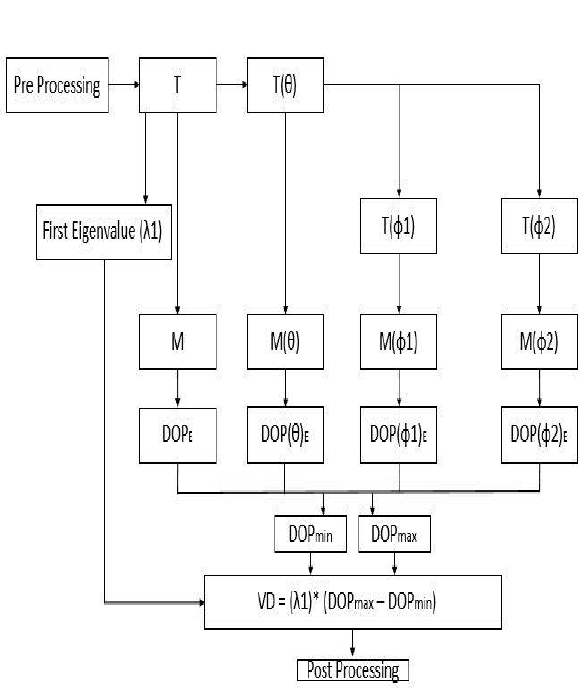
Fig. 1 Proposed Methodology